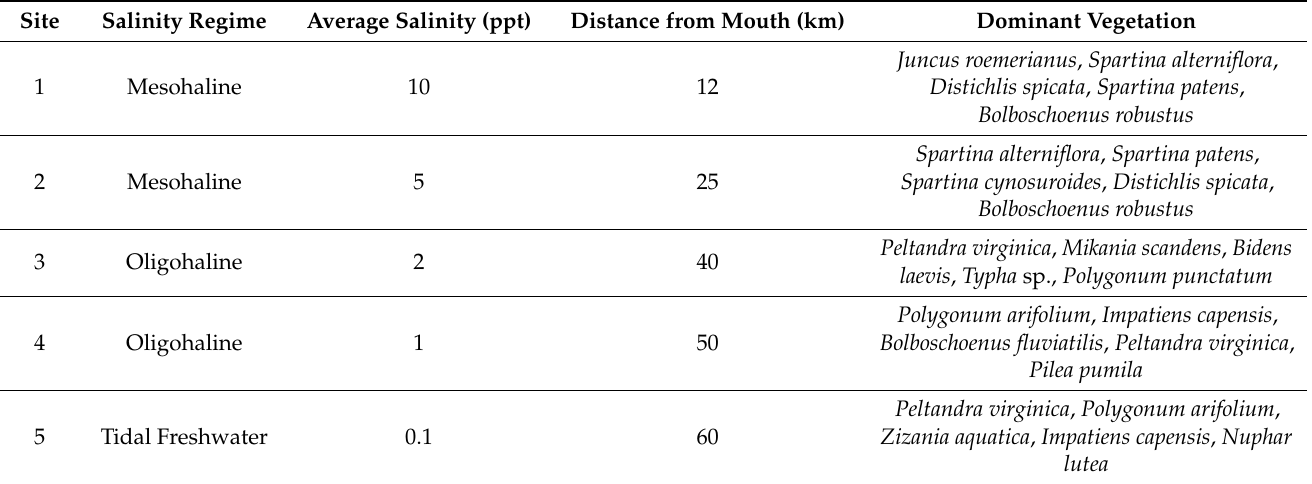
Figure 1. Location of study sites along the Nanticoke River. Each site contains three subsites. Table 1. Salinity regime, average salinity, distance from the mouth along the river channel, and the dominant vegetation for each site along the Nanticoke River (average salinity data from [30]; plant nomenclature is according to the United States Deparment of Agriculture PLANTS database, https://plants.usda.gov, accessed on 28 May